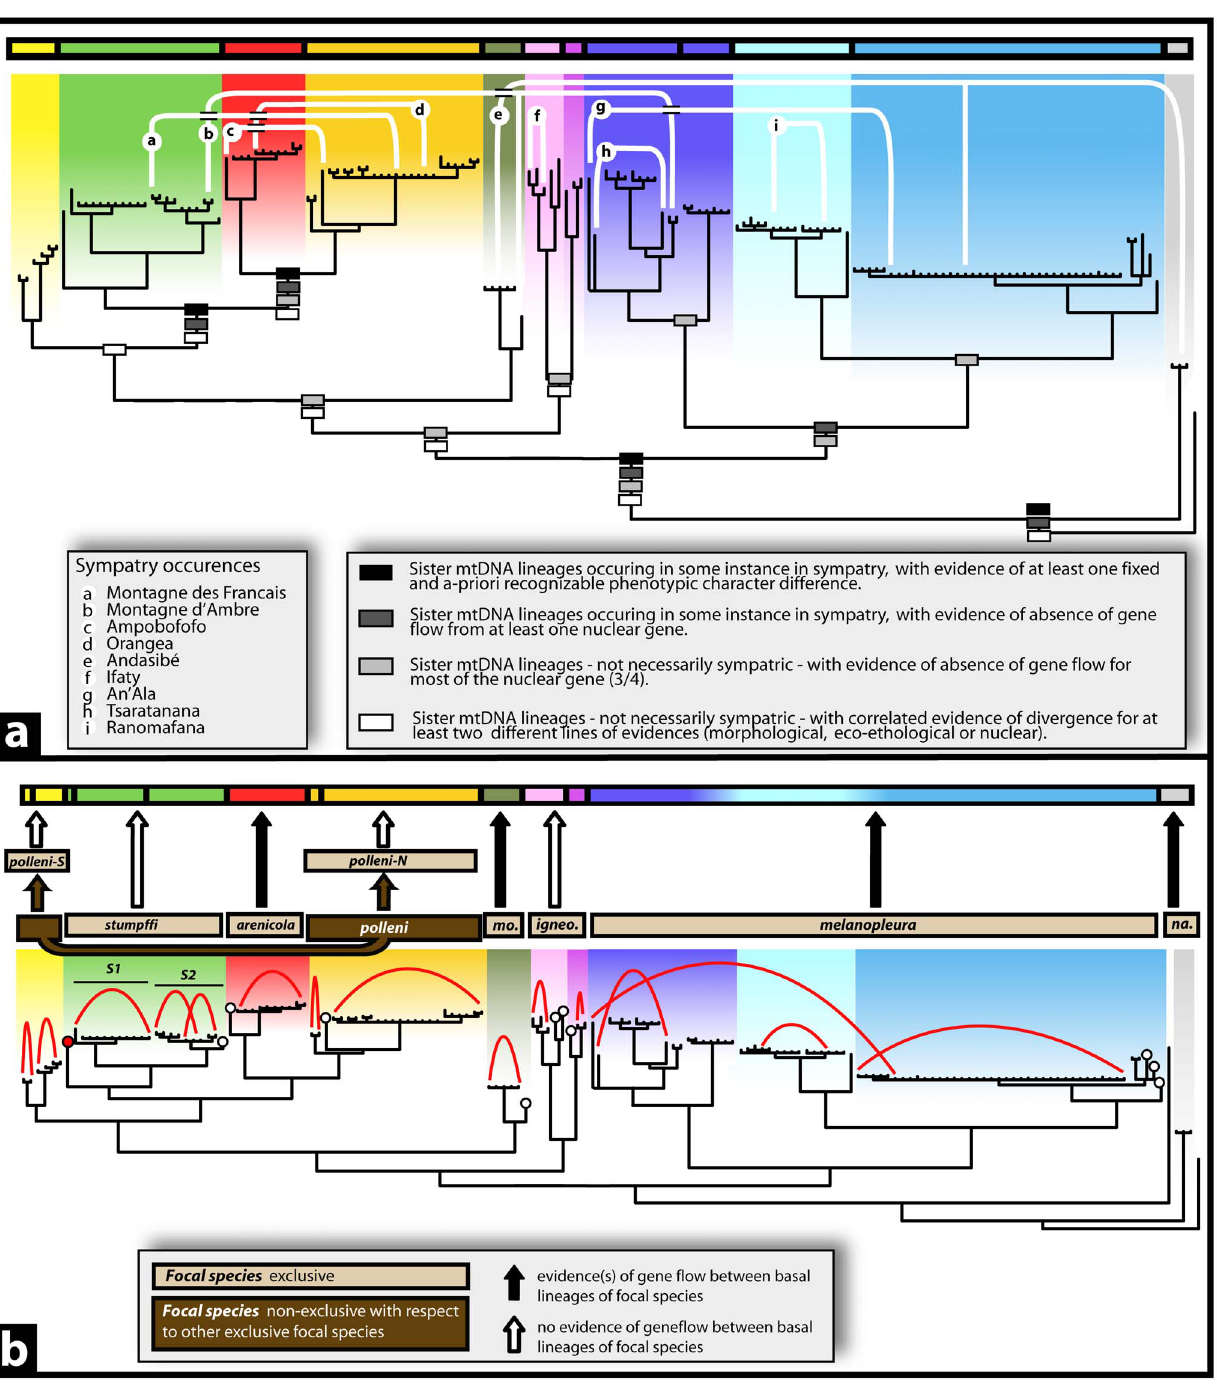
Figure 3. Results from the Integrative Taxonomic (ITAX) and Wiens and Penkrot (WP) approaches to species delimitation. Taxonomies are summarized above each figure by a horizontal multicolored bar, each segment representing a different species. A: Application of the ITAX protocol on the mtDNA gene tree. Four distinct criteria have been applied for speciation delimitation within the genus Madascincus . White lines connecting terminal taxa represent occurrences of sympatry (localities a-i) between major clades. B: Application of the WP protocol on the mtDNA gene tree. All the seven focal species tested represent exclusive haplotype lineages, with the exception of M. polleni . Two haplotypes have being considered as the minimal acceptable sampling to support the distinctiveness of a given species. Therefore, species revealed by the WP protocol that were represented by a single haplotype (white circle) were merged with their sister species. The unique sample of M. stumpffi from Antanambao (red circle) constitutes the only exception to this rule: this sample represents the sister lineage of two clades (Files S1 and S2) which are both well sampled and recovered as distinct species. Therefore, in accordance with the concept of phylogenetic species on which this protocol is based, the distinctiveness of the Antanambao sample as a third species has been validated. Red lines represent a selection of the most relevant instances of ‘‘gene flow’’ within each inferred species.